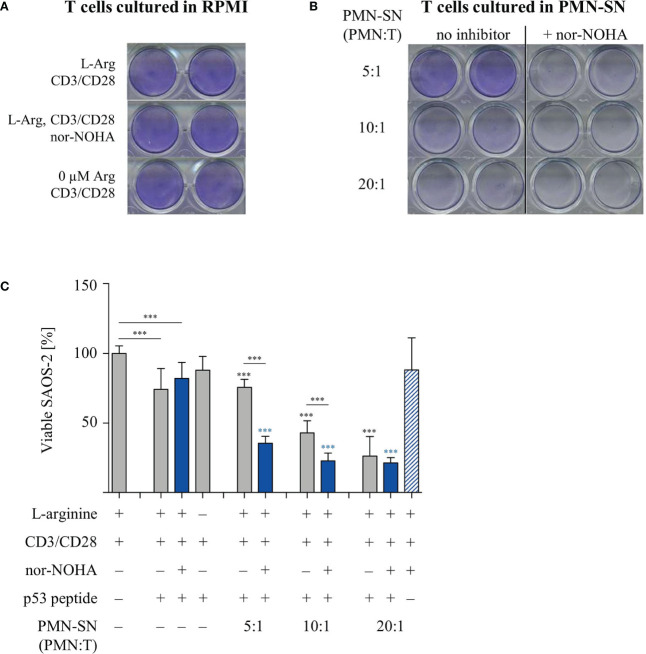
Hyperactivation of T cell cytotoxicity is induced by polymorphonuclear neutrophil granulocytes supernatants (PMN-SN) and further increased by arginase inhibition. Human T cells and PMN were isolated from whole blood of healthy donors. Human T cells were retrovirally transduced with an HLA-A2 restricted p53(264-272)-specific T cell receptor and expanded by weekly restimulation with anti-CD3/anti-CD28-tagged beads and later via p53 peptide-loaded K562-A2.1 cells. PMN were incubated in cell culture medium for 72 h in the presence or absence of the arginase inhibitor nor-NOHA (1 mM). T cells were stimulated with anti-CD3/anti-CD28-tagged beads and cultured in the PMN-SN for 48 h. SAOS-2 cells, pulsed with p53(264-272) peptide as indicated, were cultured for 3 h with T cells (A) in the absence or (B) in the presence of PMN-SN at the indicated conditions. SAOS-2 cells were then stained with crystal violet to detect viable cells. (C) Quantification of viable SAOS-2 cells (n=3 independent experiments): OD values of control SAOS-2 cells (see
Supplementary Figure S2
) were set as 100% and OD values of the different experimental conditions were normalized to these controls. Statistical analysis: if not otherwise indicated, black asterisks refer to the control condition of SAOS-2 cells without p53 peptide (leftmost column), while blue asterisks refer to the control condition of SAOS-2 cells pulsed with p53 peptide and incubated with T cells in the absence of PMN-SN (leftmost blue column). Statistical calculations were performed with one-way ANOVA and Tukey´s post hoc test (***p < 0.001).